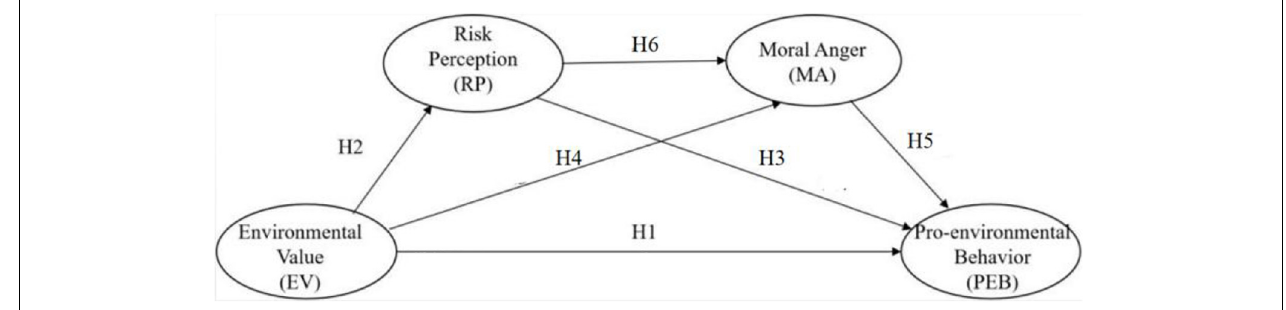
FIGURE 1 | Conceptual model of hypothesis path (H) indicating causal relationships between each variable.